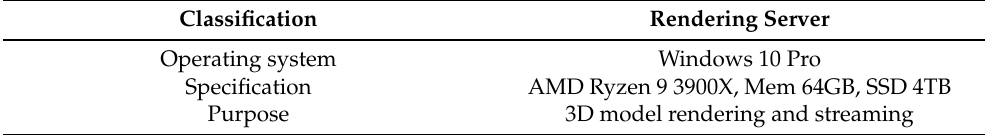
Table 3. Implementation of Rendering Server.